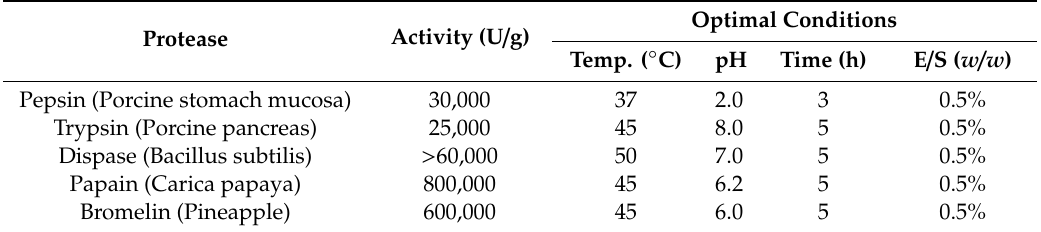
Table 8. Optimal reaction conditions of five